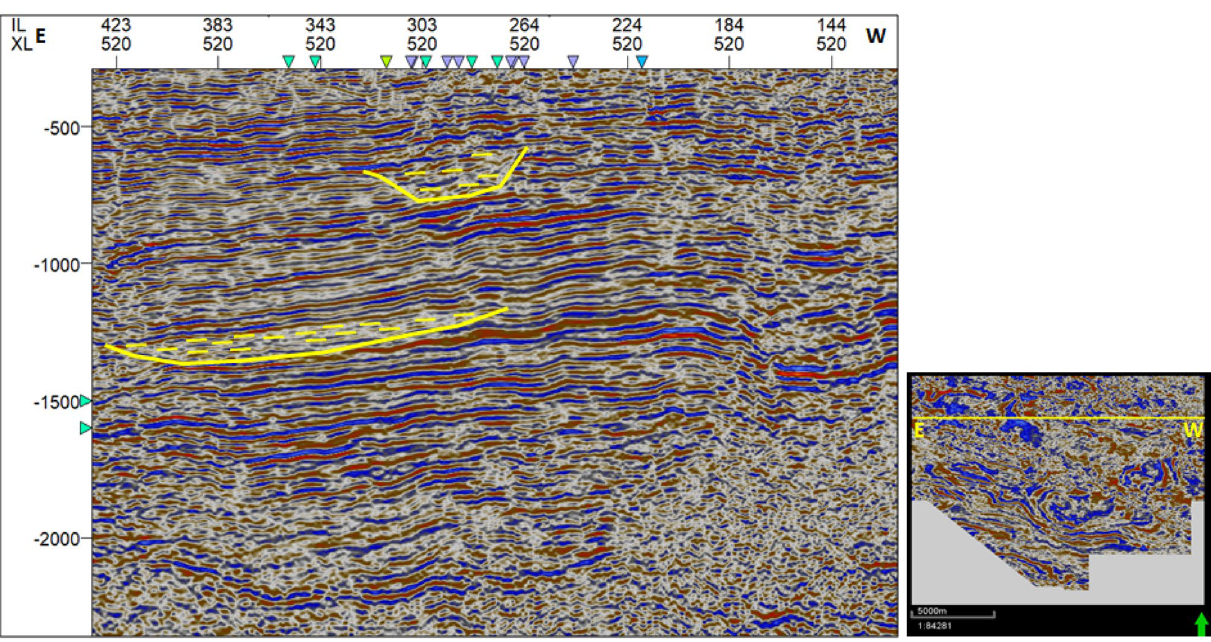
Fig. 12 Channel incisions up-north from Izombe seismic survey—line 2